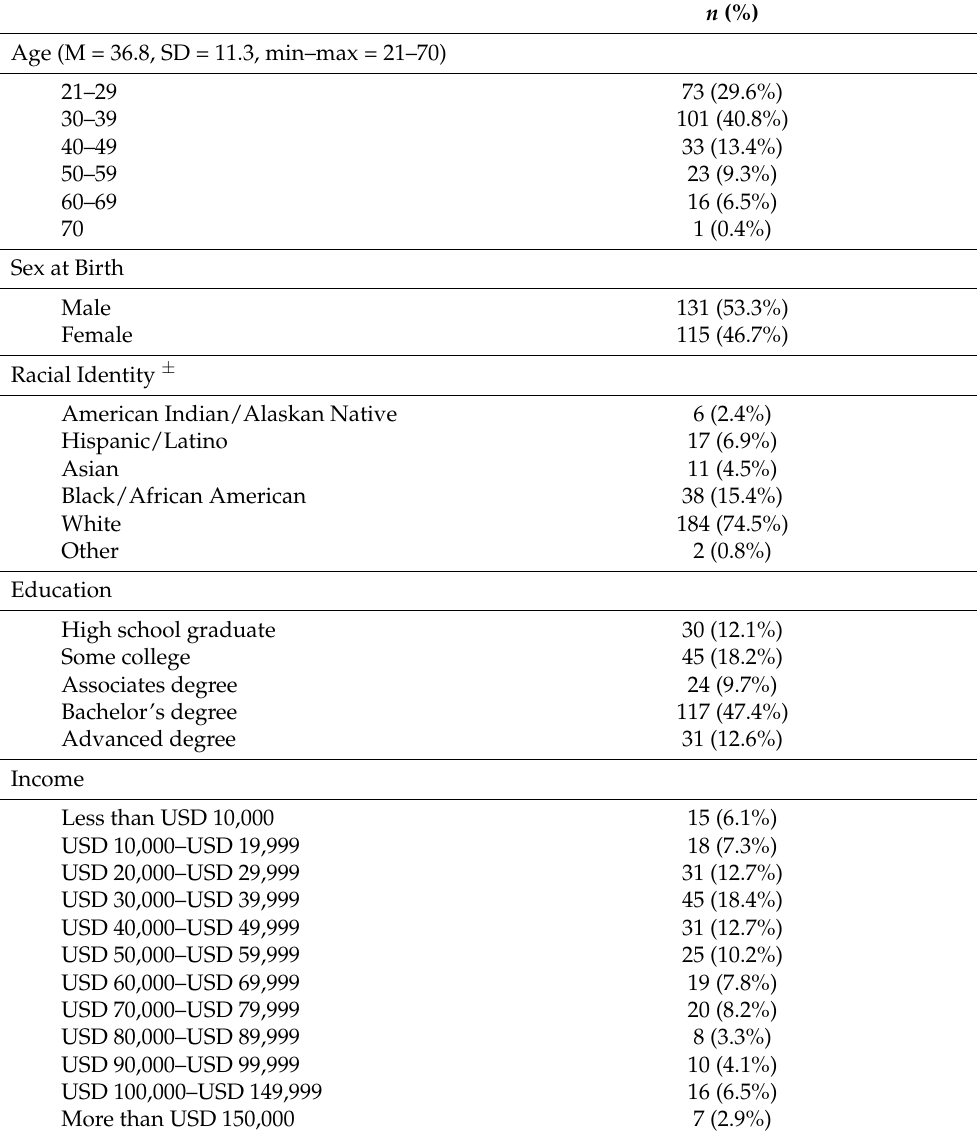
Table 1. Demographic